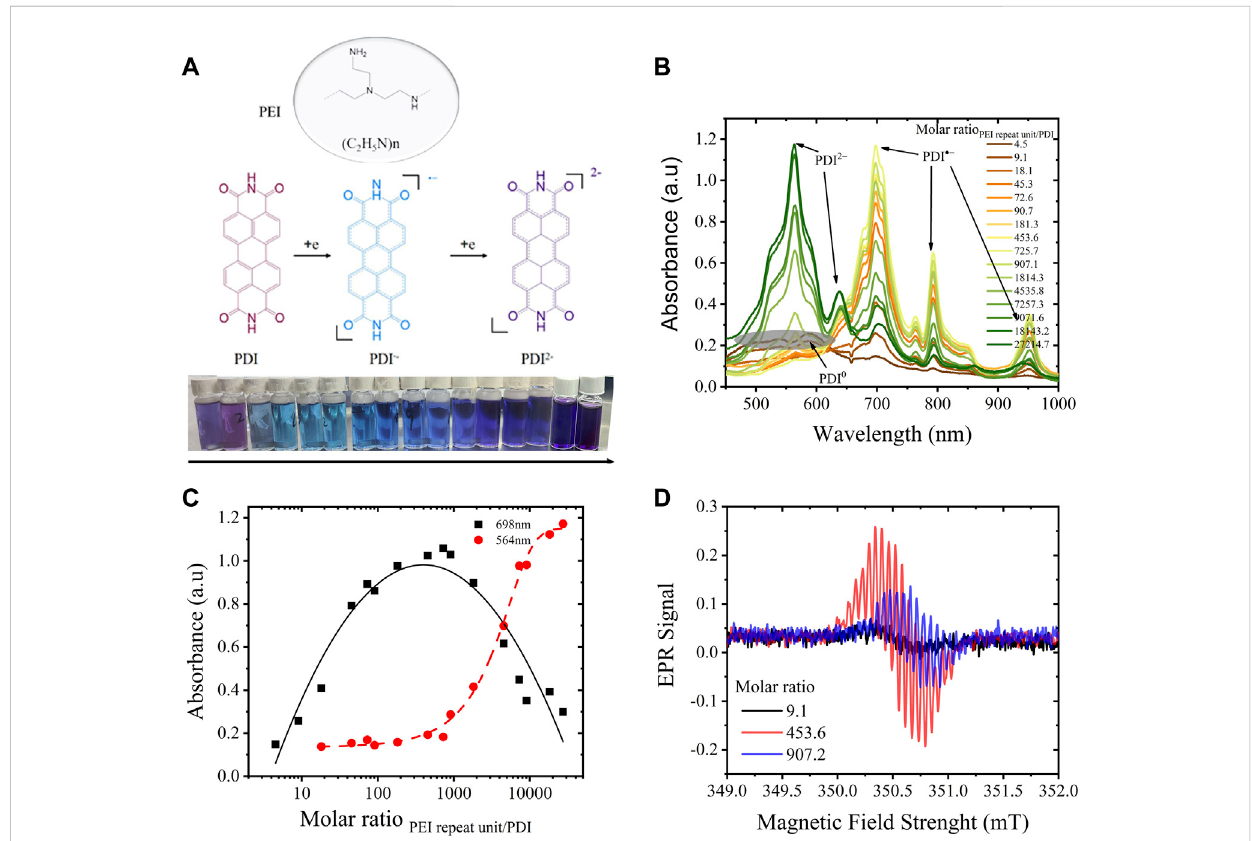
FIGURE 1 (A) Chemical doping of PDI (0.04 mg/mL in DMF) by various amounts of PEI to form radical anions/dianions; (B) UV-vis spectra of the reduced PDI- PEI suspensions, the molar ratio of PEI repeat unit/PDI increase from 4.5 to 27215; (C) aplotof theintensity of absorption at 698 nm, 564 nm assignedto PDI-and PDI2-, vs molar ratio of PEI repeat unit/PDI; (D) Electron paramagnetic resonance spectra of PDI suspension doped with PEI content under a molar ratio of PEI repeat unit to PDI equals to 9.1, 453.6 and